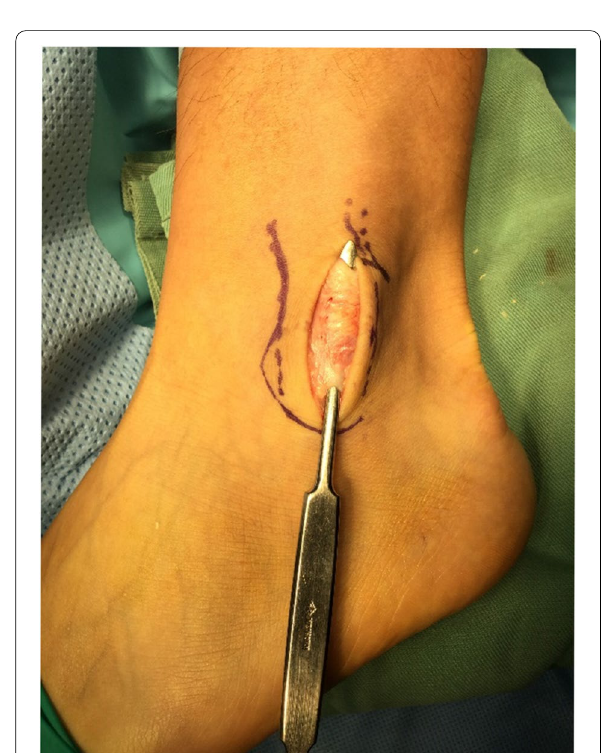
Fig. 3 Opening of the proximal and distal ends of the false-pouch. Small incisions are made at the proximal and distal ends of the false-pouch, and the surface of the fibula is